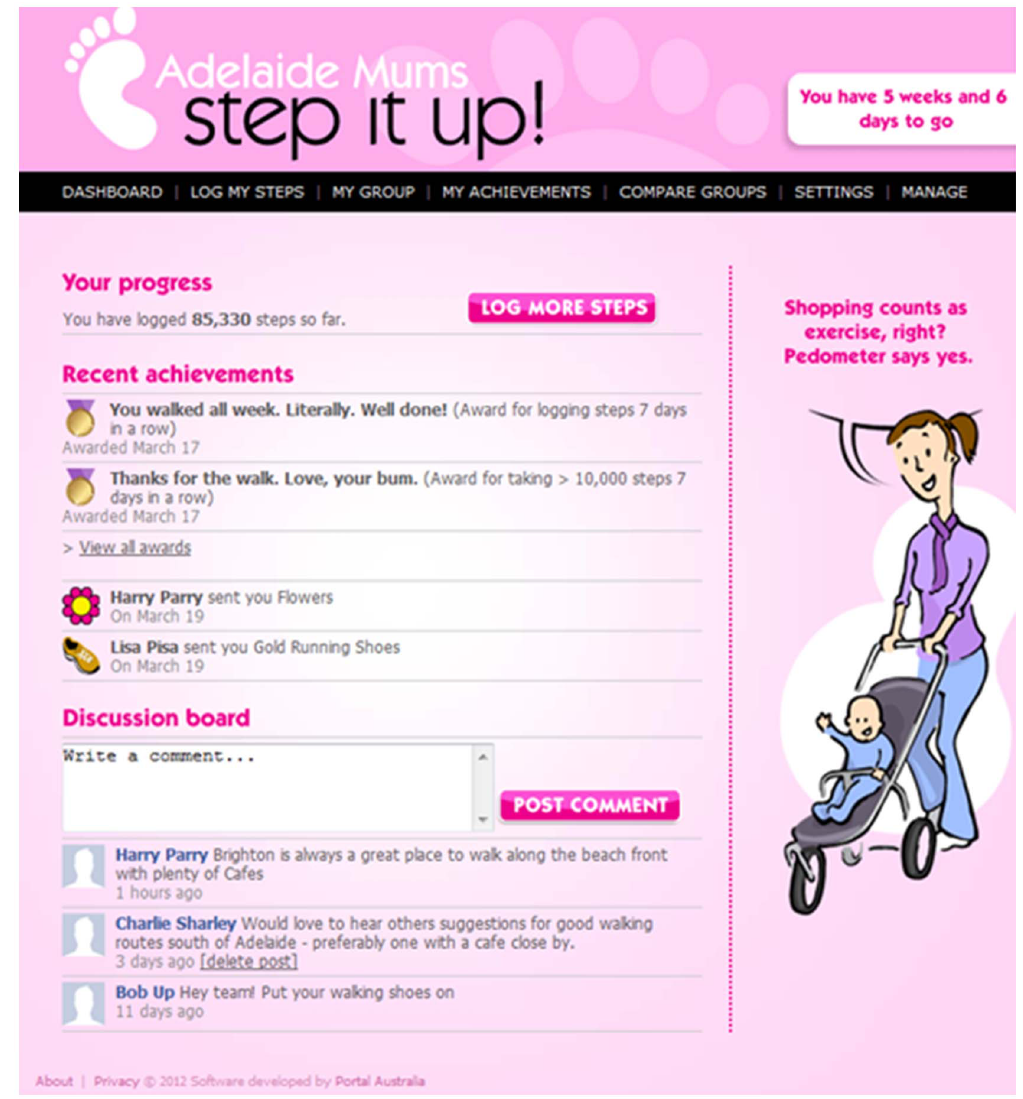
Figure 2. Screen shot of the dashboard of the Mums Step It Up app. The Dashboard provides links to all of the other pages.